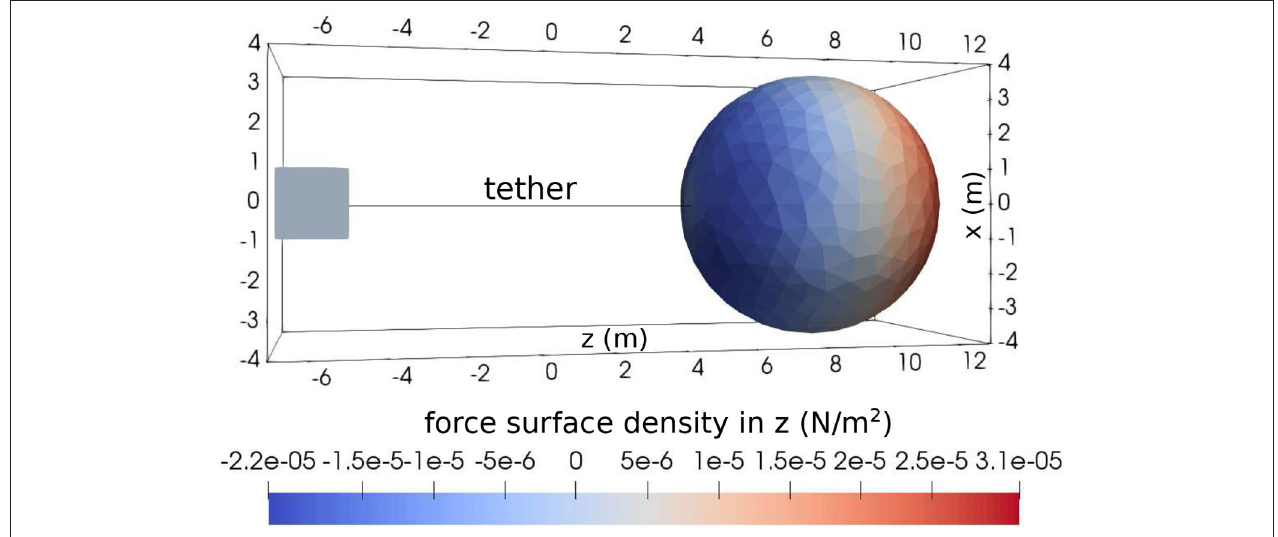
FIGURE 1 | Illustration of the spacecraft, tether, and spherical capacitor geometry assumed in the simulations. The colors on the sphere show the component of the electric force surface density along z , computed at t = 5.5 ms in the time dependent simulation.